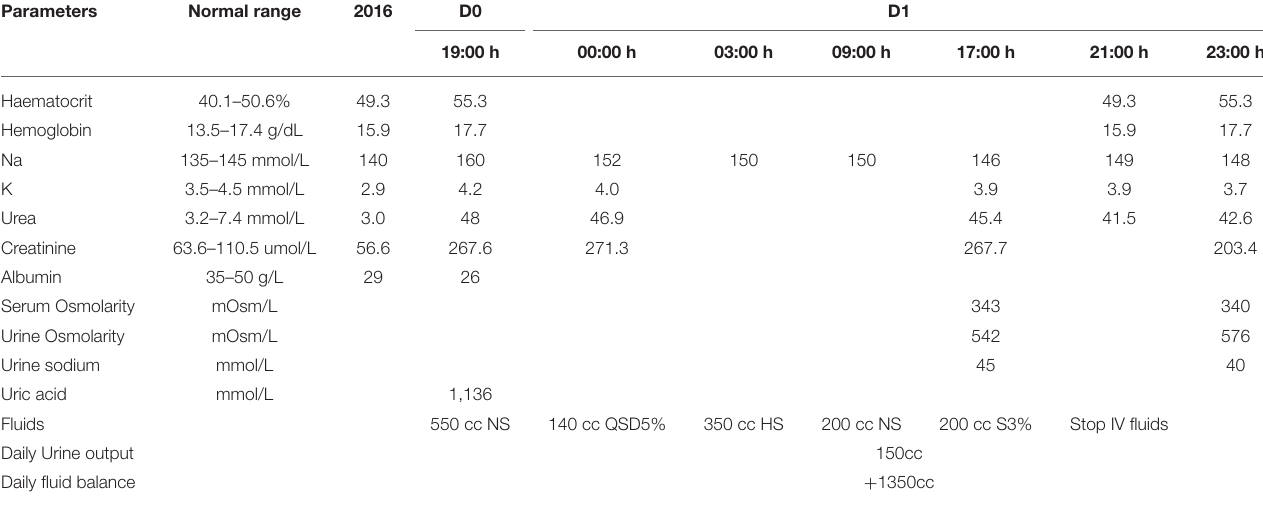
TABLE 1 | Biochemical parameters from day of admission till day 1 of hospital stay.